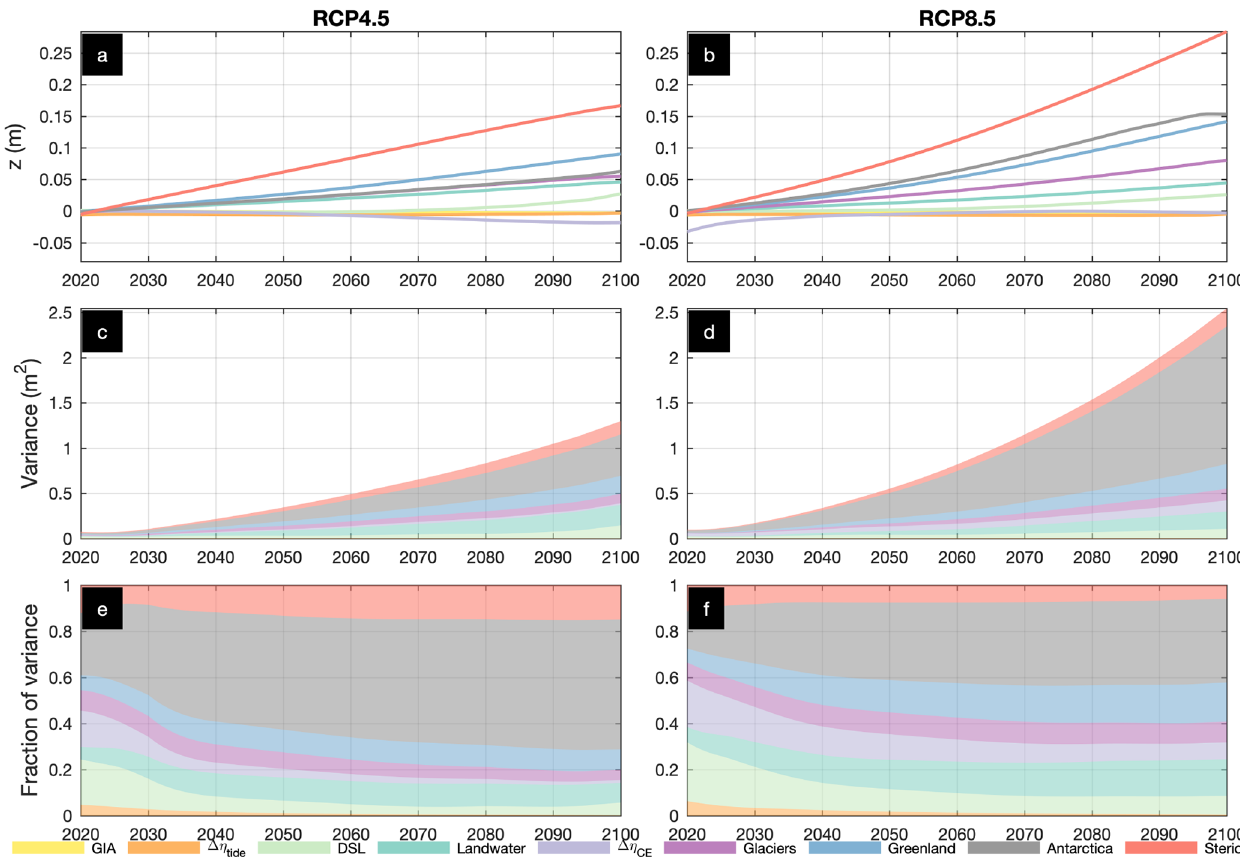
Figure 11. Breakdown of projected 100-year ESL contributions in the north-western Adriatic Sea and of their uncertainty under RCP4.5 (a, c, e) and RCP8.5 (b, d, f) . Projected increase in the 100-year ESL (with respect to the 2001–2020 baseline) from changes in climate extremes and the high-tide water level as well as MSL rise contributions from Antarctica, land water, Greenland, glaciers, dynamic sea level (DSL), glacial isostatic adjustment (GIA), and steric effects (a, b) ; variance (in square metres) in components (c, d) and fraction of components’ variance in global 100-year ESL change. Colours represent different components as in the legend, and values express the median. This figure follows the same graphic format, and it is based on the same simulations shown in Vousdoukas et al. (2018), but it specifically refers to the area marked with the red box in Fig.